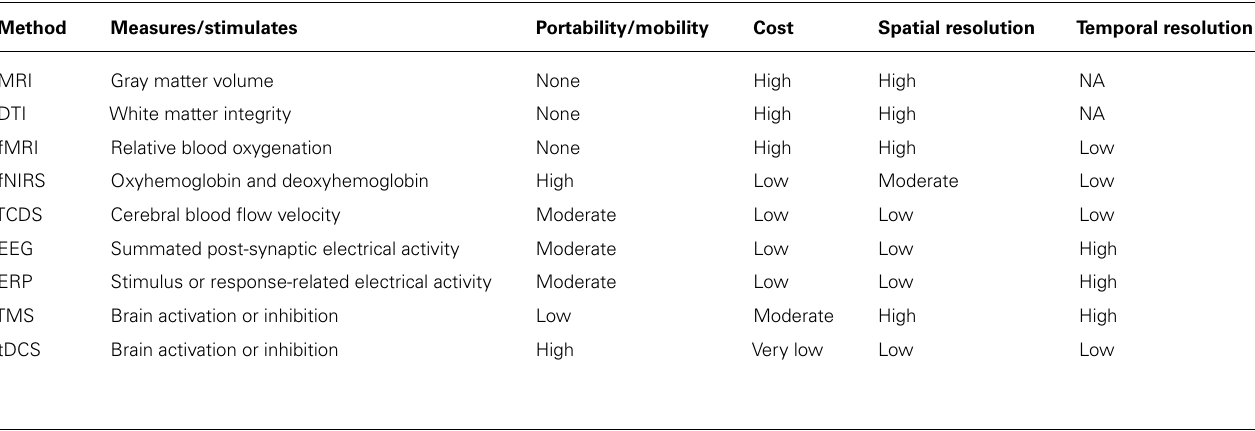
Table 1 | List of neuroergonomic techniques and their major features.